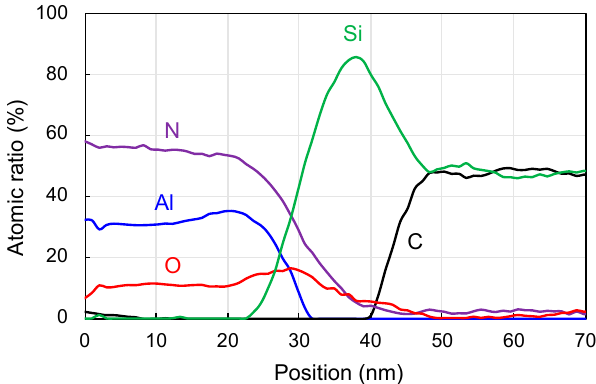
Figure 5. Electron energy loss spectroscopy (EELS) scanning along the white line in Figure 4a. The profiles of Si, C, Al, N, and O are represented by green, black, blue, purple, and red.